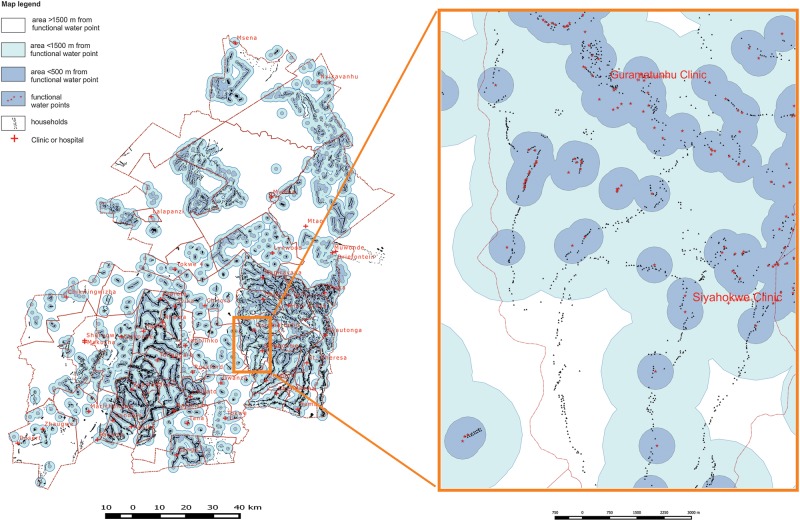
Spatial water coverage by functional, protected, perennial, and unrestricted water points across the Sanitation Hygiene Infant Nutrition Efficacy study area. The insert shows households that fall into the 3 regions: within <500 m, <1500 m, and >1500 m of a water point.